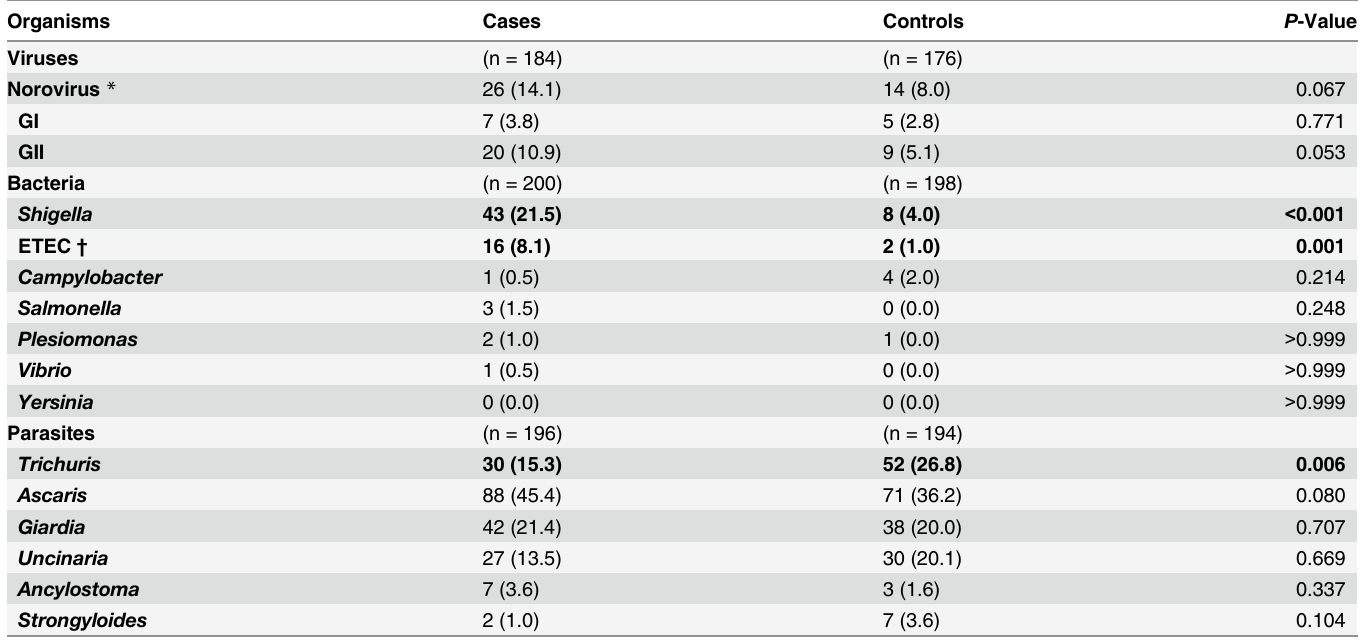
Table 1. Stool analysis results of cases verus controls, no.